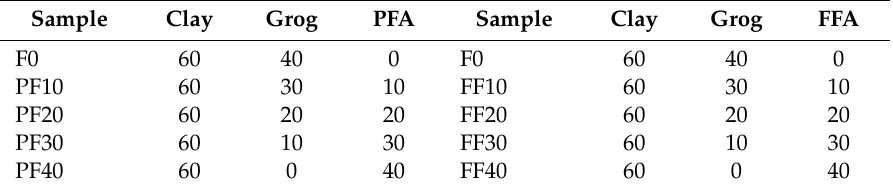
Table 3. The composition of the studied PF and FF samples (in